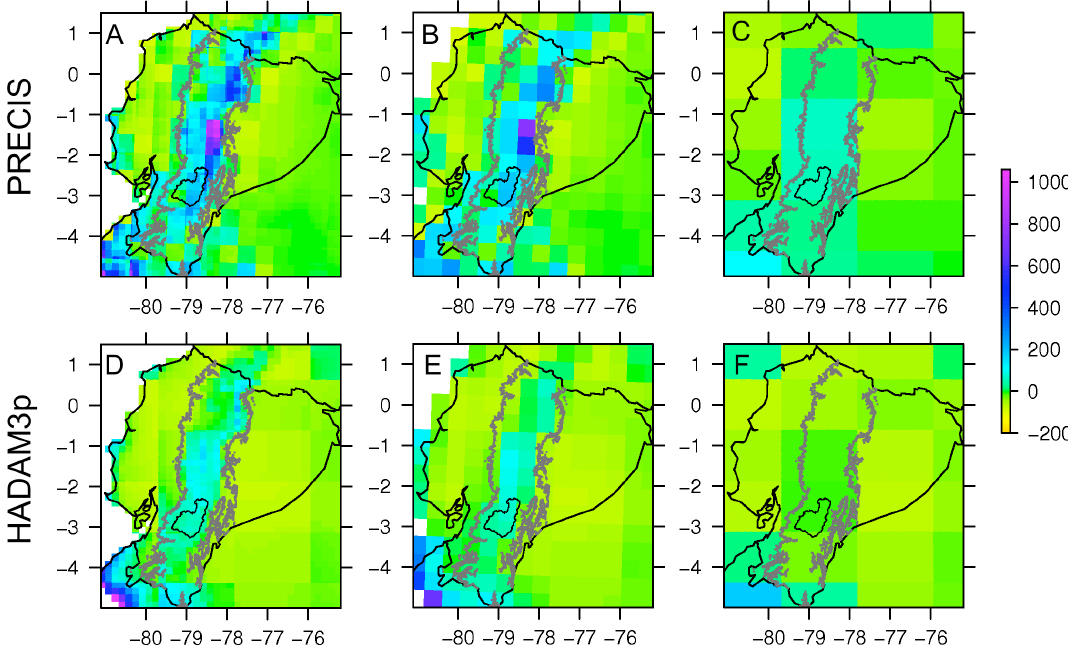
Fig. 5. Bias (%) of the PRECIS and HadAM3p control run for precipitation compared to the observed climatology at three different resolutions. A and D : climatology resolution (0.167 ◦ ); B and E : PRECIS resolution (0.5 ◦ ); C and F : HadAM3p resolution (1.25–1.875 ◦ ). Note that the actual averaging area of some PRECIS and HadAM3p grid cells is lower due to the unavailability of climatology data over the ocean. The 1000m contour line of the Ecuadorian Andes is indicated in grey, and the Paute basin in